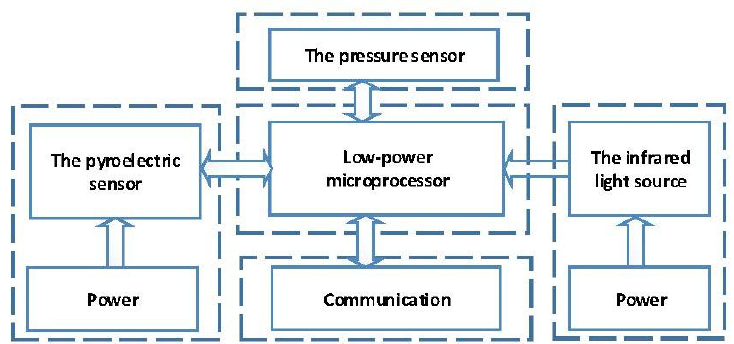
Figure 1. Framework of the detection